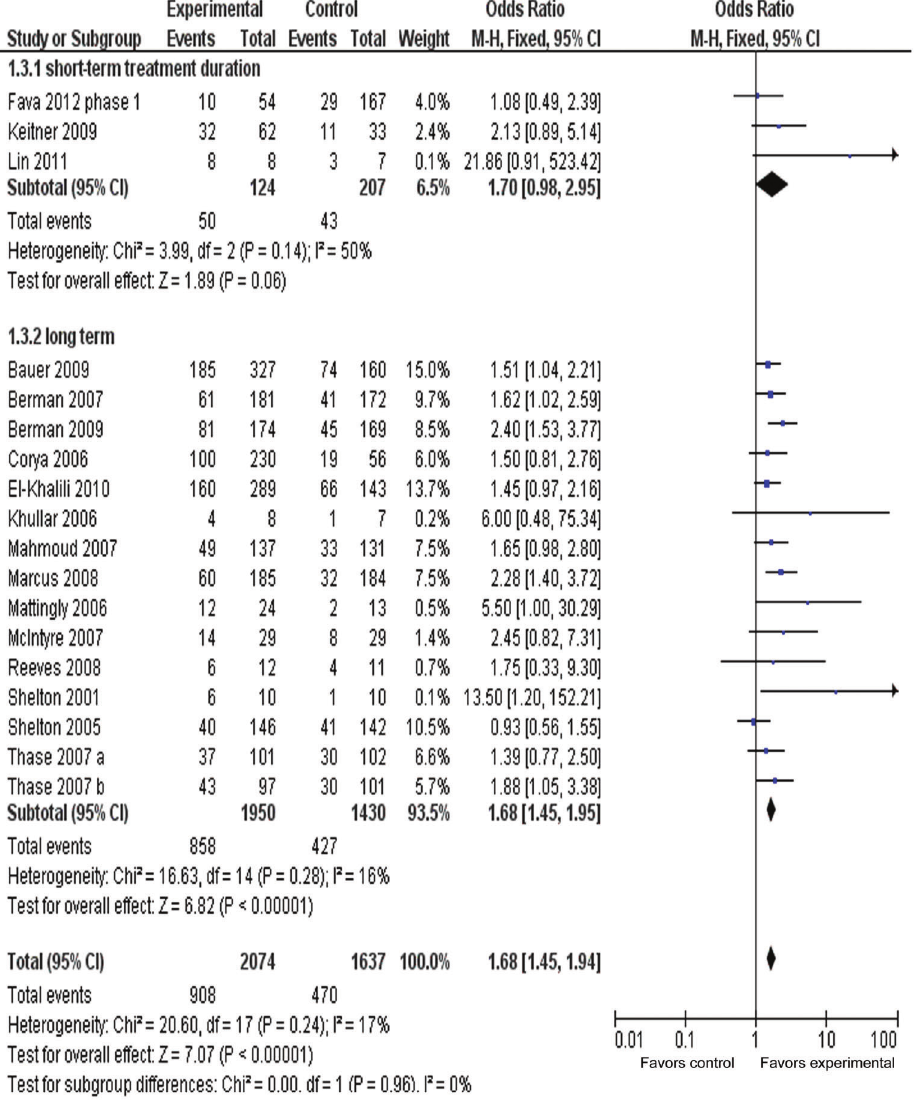
Figure 5. Meta-analysis of response rates in short-/long-term adjunctive treatment of atypical antipsychotics in major depressive disorder. Odds ratios for response to drug and placebo are grouped by short-term (4 weeks) or long-term (longer than 4 weeks) treatment duration. Thase et al. (29) contains two identical trials. All trials were included in this subgroup